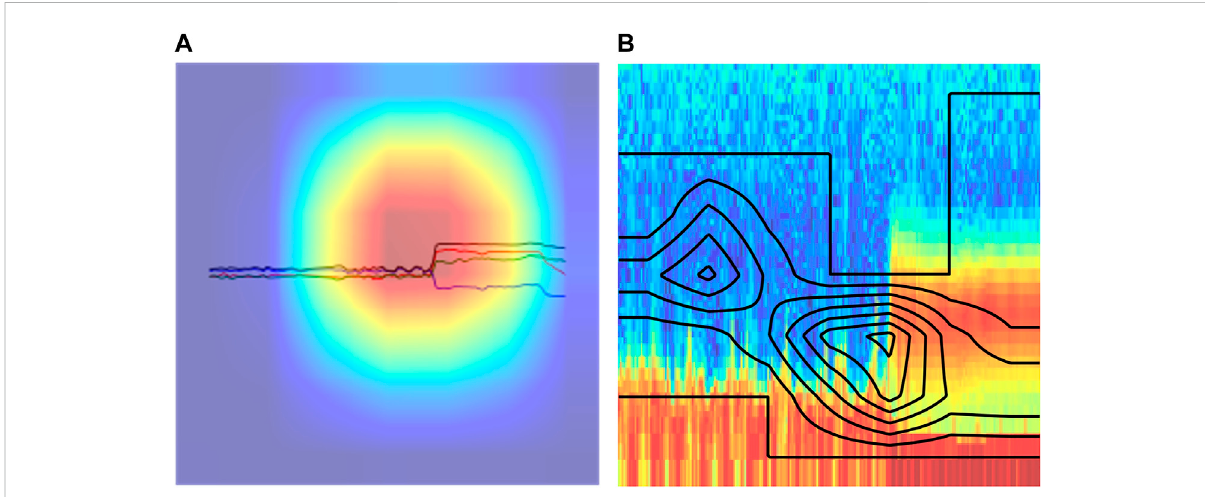
FIGURE 8 Grad-CAMappliedtocnn-mag (A) andcnn-caps (B) imagesfortheinterval2012-03-2123:30:00to2012-03-2201:30:00.Theheatmapshows regions which are most discriminative for the output class. For the MAG image (A) , the red regions highlight the most important pixels for the target class. For the CAPS image (B) , the regions with more contour lines indicate the most important pixels for the target class. Both models highlight the region with discontinuity as most important, which is what our eyes would focus on for deciding between crossing or not. The y-scale of the MAG image ranges from -10 nT to 10 nT. The y-scale of the CAPS image ranges from 0.6 eV to 28.25 keV on a logarithmic scale consisting of the 63 energy bins of the CAPS ELS instrument. Both images show the same 2-h interval of Cassini